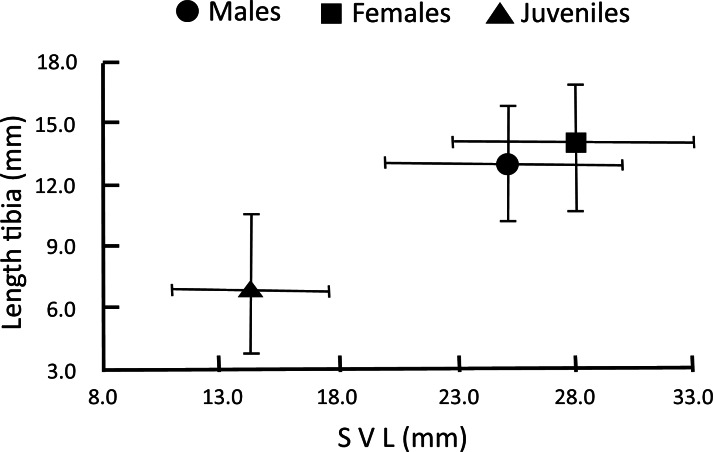
Age-sex categories of H. eximia defined by the generalized analysis of k-means on sex-body size.Juveniles (SVL < 20 mm), adult males and adult females (SVL ≥ 20 mm).